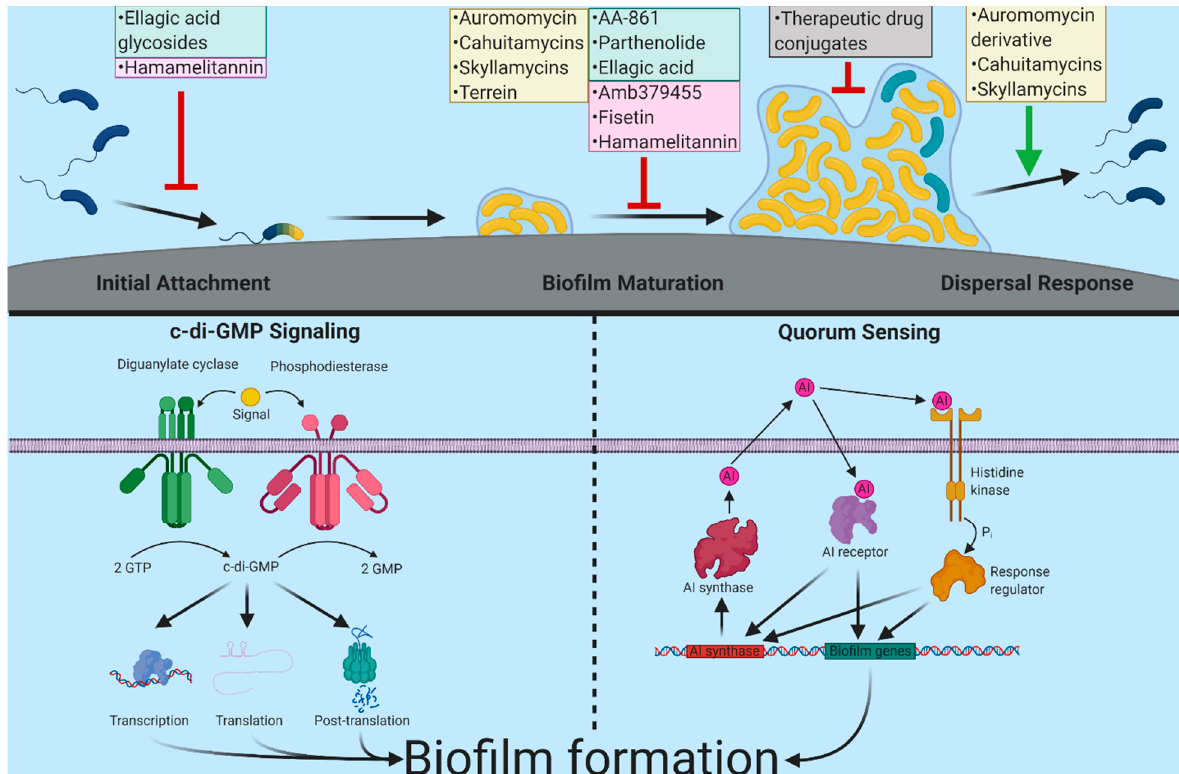
Figure 1. Biofilm inhibitors and their targets discussed in this review. Biofilm formation starts when planktonic cells (colored blue) sense and attach to the surface. Following this, surface-attached cells (colored yellow) begin to divide, recruit nearby cells, and produce biofilm matrix components and form microcolonies and eventually mature biofilms. In response to cellular signals or external cues, biofilms can disperse, and dispersed cells can colonize new environments. Major inhibitors covered in this review, as well as their discovery method, are shown by color. High throughput discovery is represented by yellow, targeted/pathway discovery by green, in silico discovery by pink, and therapeutic drug conjugates in grey. A schematic of two major regulatory systems governing biofilm formation c-di-GMP signaling and quorum sensing (QS) are indicated. C-di-GMP is produced by diguanylate cyclases (DGCs) and degraded by phosphodiesterases (PDEs). Signals can impact the enzymatic activity of these enzymes allowing for control over the intracellular concentrations of c-di-GMP. These changes in c-di-GMP can be sensed by receptors that affect transcription, translation, and activity or stability of biofilm-associated genes/proteins. Bacteria use quorum sensing to determine cell density. These systems produce an autoinducer compound, which is secreted into the environment. QS signals are then sensed by periplasmic proteins, membrane-bound histidine kinases or cytosolic receptors and initiate signal transduction pathways regulating biofilm gene expression. Created with BioRender.com.